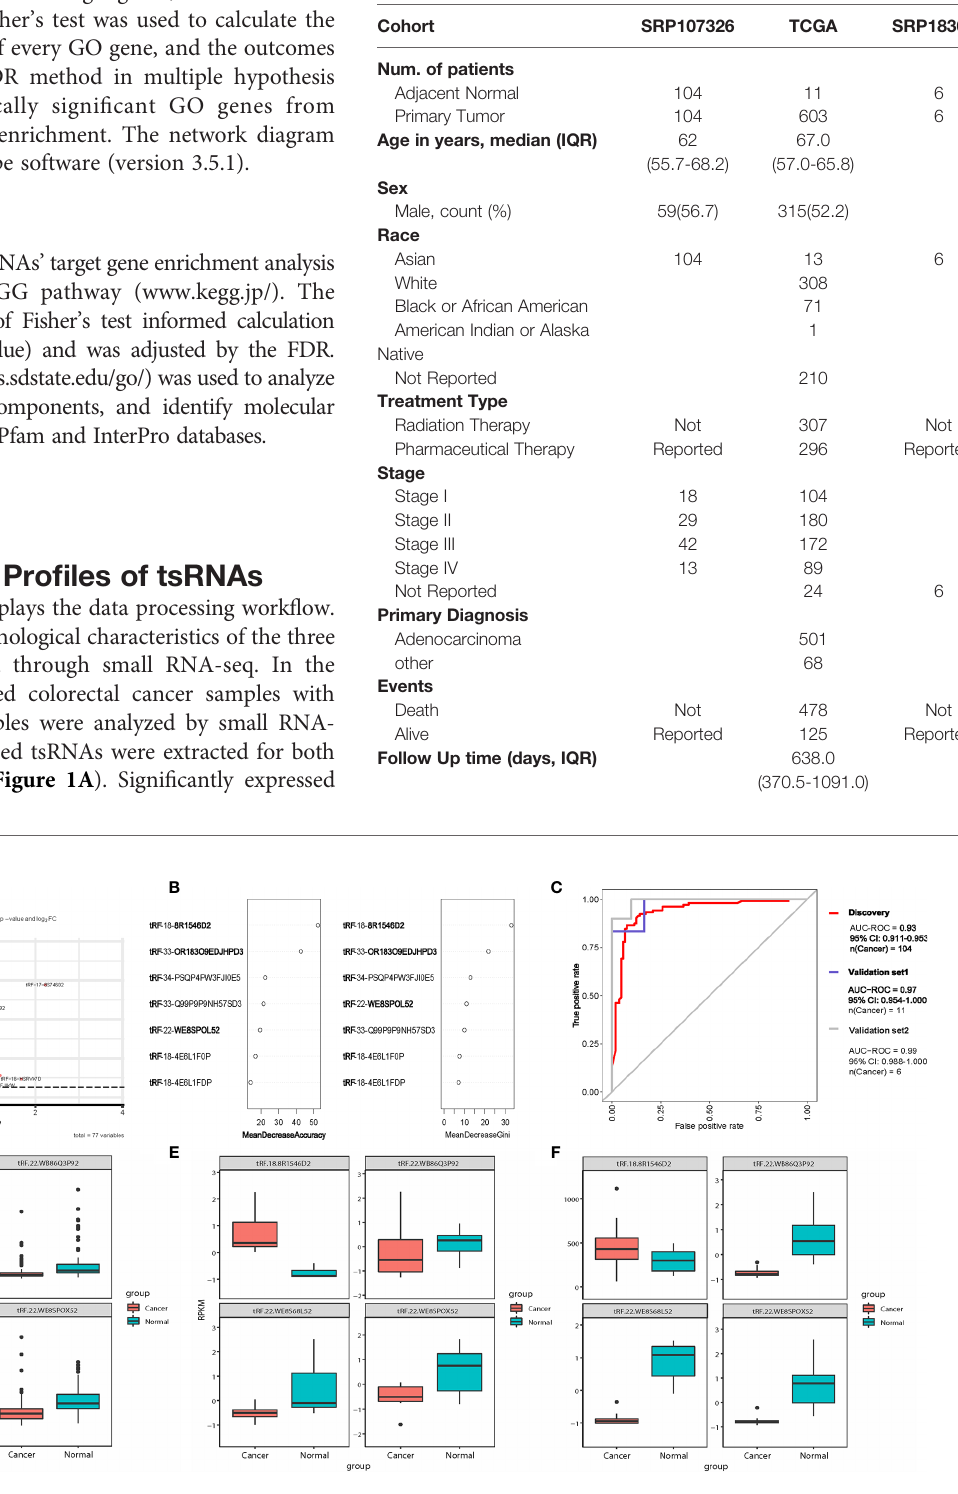
FIGURE 1 | tsRNA diagnostic panel. (A) Volcano plot of differentially expressed tsRNAs between normal and cancer. (B) Random forest RF mean decrease of accuracy and mean decrease Gini score rank. (C) ROC curve of the diagnostic prediction model with tsRNA markers in the discovery data and two independent validation data sets. (D – F) Four model selected tsRNA expression in discovery dataset and two independent validation data